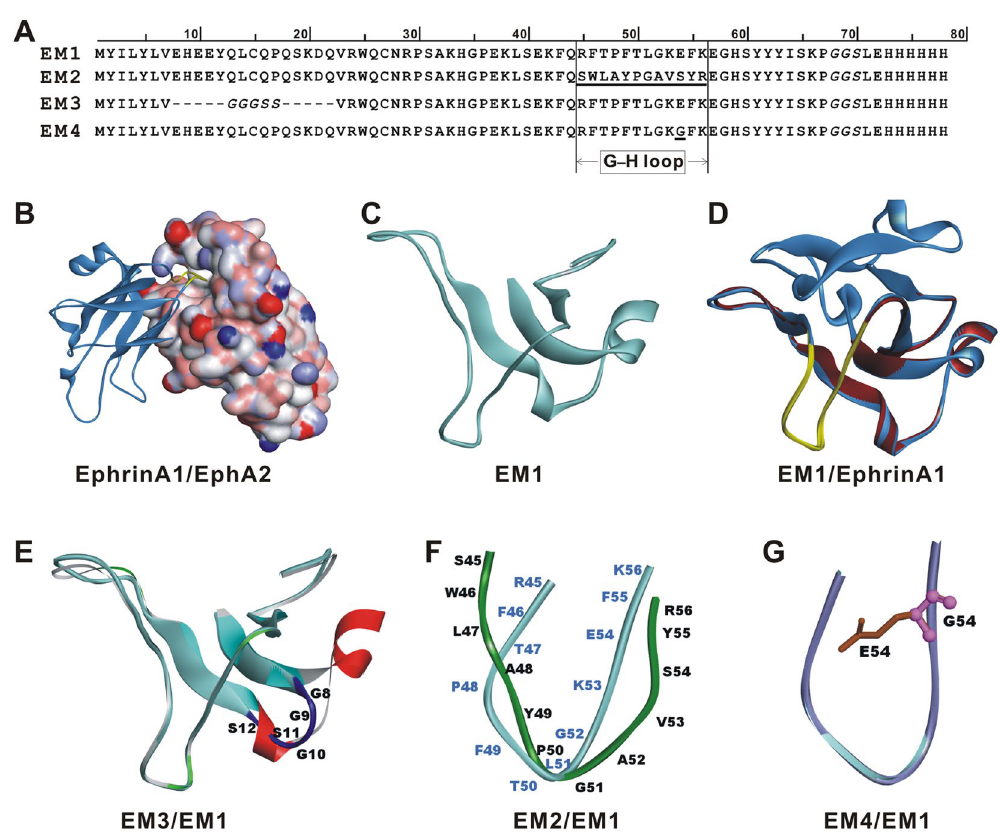
Figure 1. Protein sequences and the molecular models of EphrinA1 mutants. ( A ) The mutated amino acids in G–H loop are underlined and the flexible linker residues are shown in italics. ( B ) Overview of EphrinA1-EphA2 complex (PDB ID: 3HEI). EphrinA1 is in solid ribbon and EphA2 is in surface model. ( C ) The homology model of EM1. ( D ) EM1 (colored in red) superimposes with EphrinA1 (colored in medium blue). The G–H loop is highlighted in light yellow. ( E ) Superposition of EM3 with EM1. The α -helix (colored in red)-deleted EM1 is linked by GGGSS linker (colored in blue) in EM3. ( F ) Structure-sequence alignment of the crucial loop between EM1 (colored in light cyan) and EM2 (colored in green). ( G ) Single E54G mutation in G–H loop of